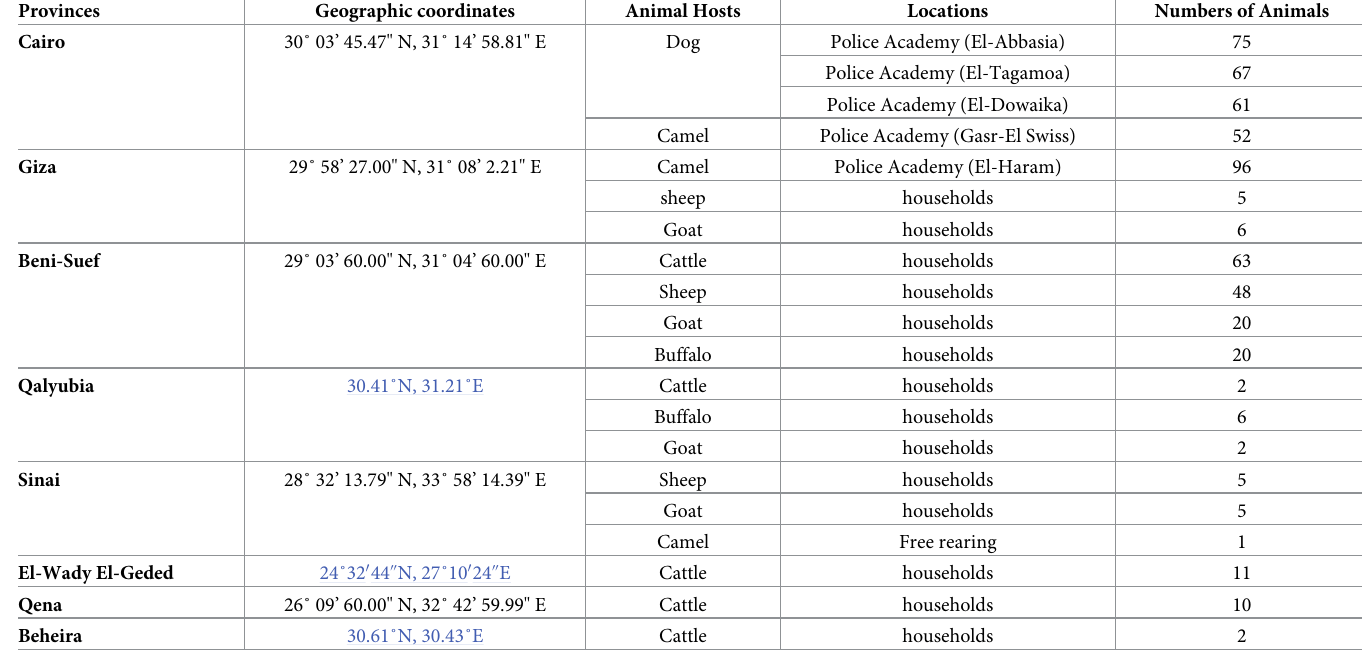
Table 1. The information data of collected samples.